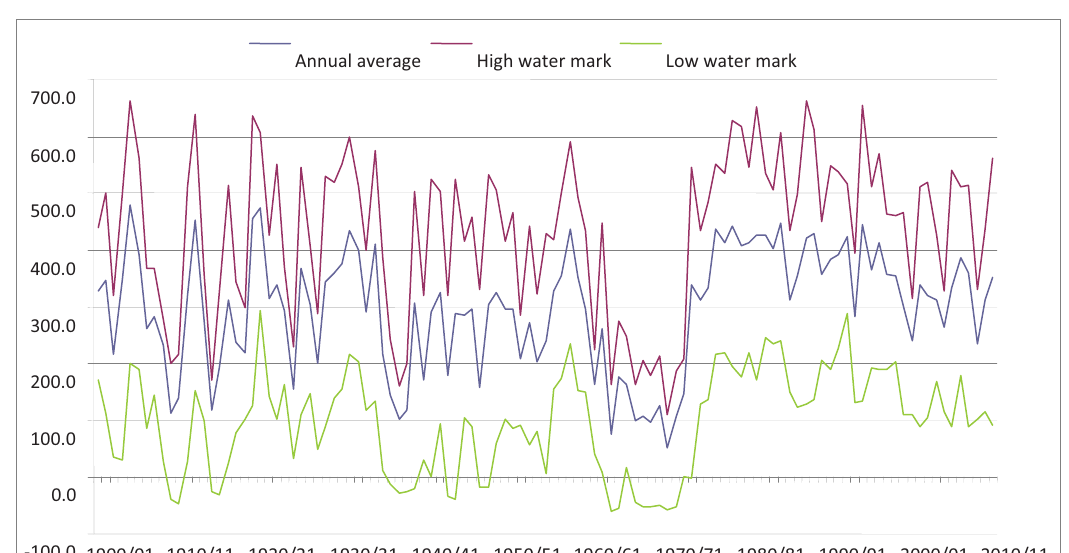
Figure 2. Historical events of flooding in the Pantanal during the last 111 years (January 1900 through November 2011), observed on the Paraguay River recorded by the flood gauge of the fluviometric station at